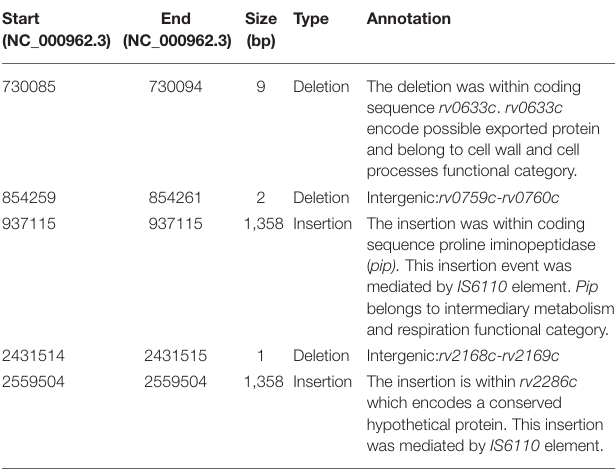
TABLE 3 | Structural variation common to